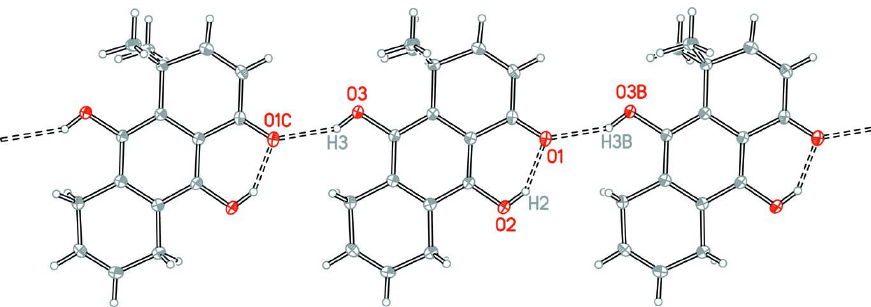
Molecular packing view for I along [010]. [symmetry codes: (B) x + 1, y , z ; (C) x - 1, y , z